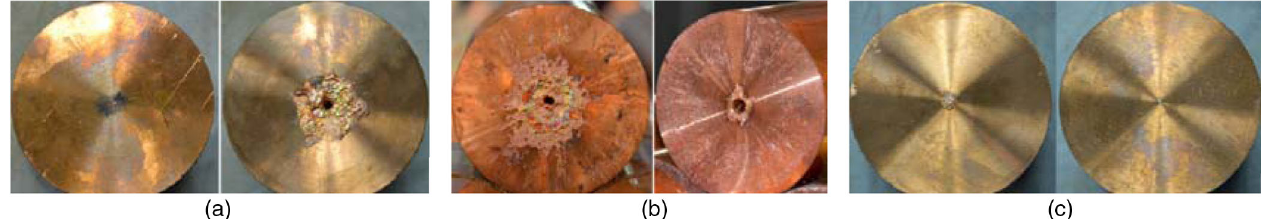
FIG. 1. Target 3 after irradiation, front face (left) and back face (right) of (a) the first cylinder, (b) the fifth cylinder, and (c) the ninth cylinder. Each cylinder is 10 cm long with a radius of 4